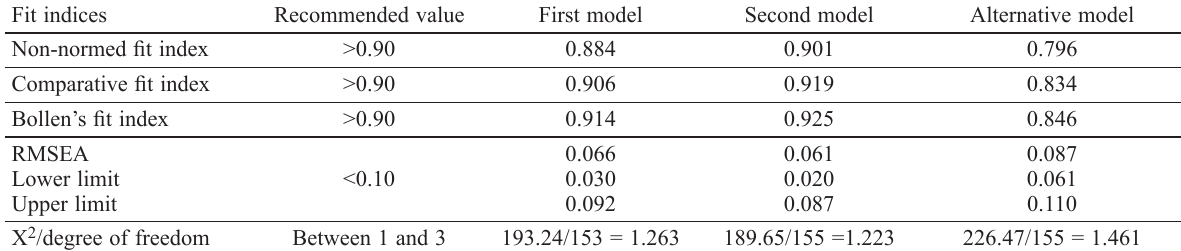
Table 2. Fit Indices of the models